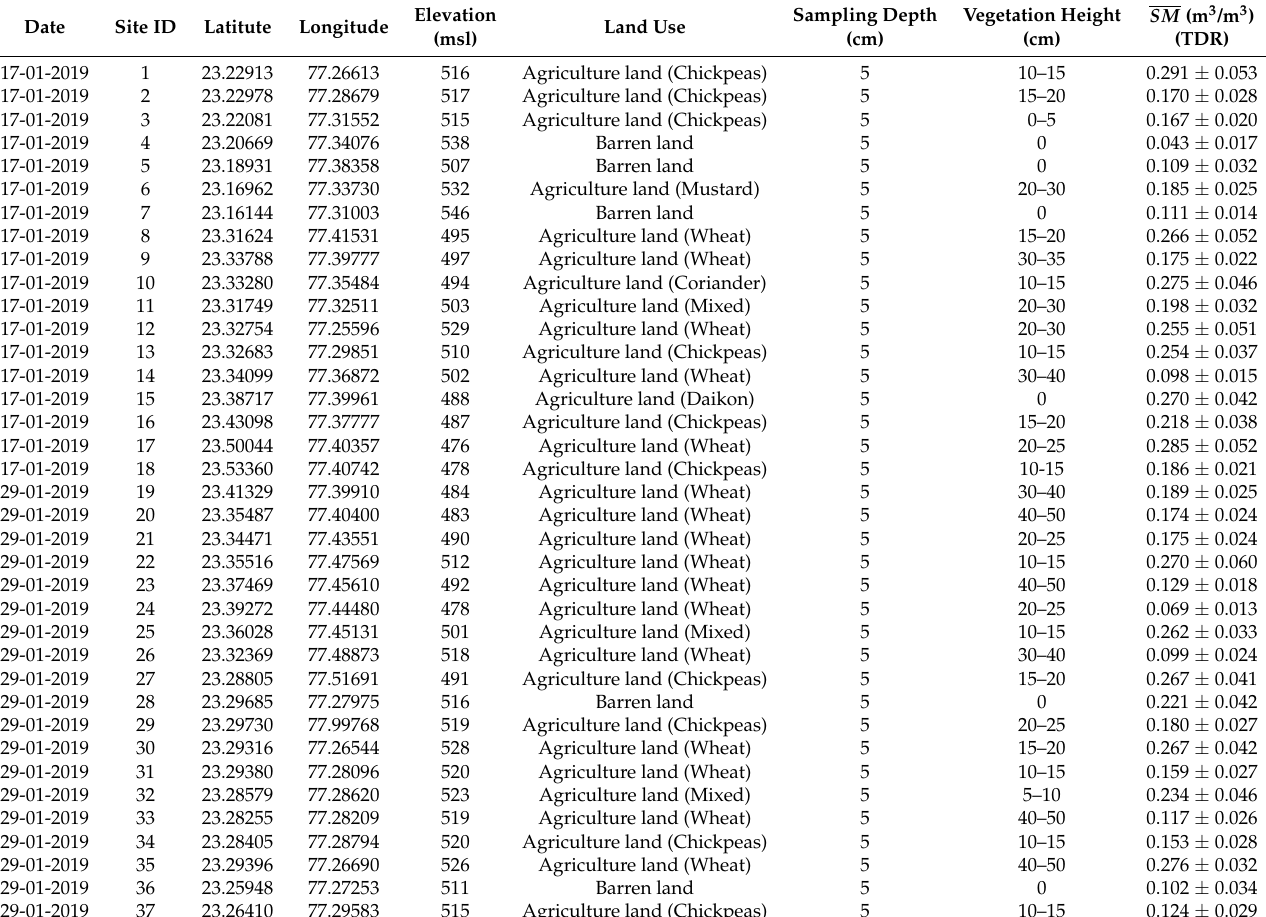
Table 2. Details of the ground condition and soil moisture measured in the field using ML3 theta